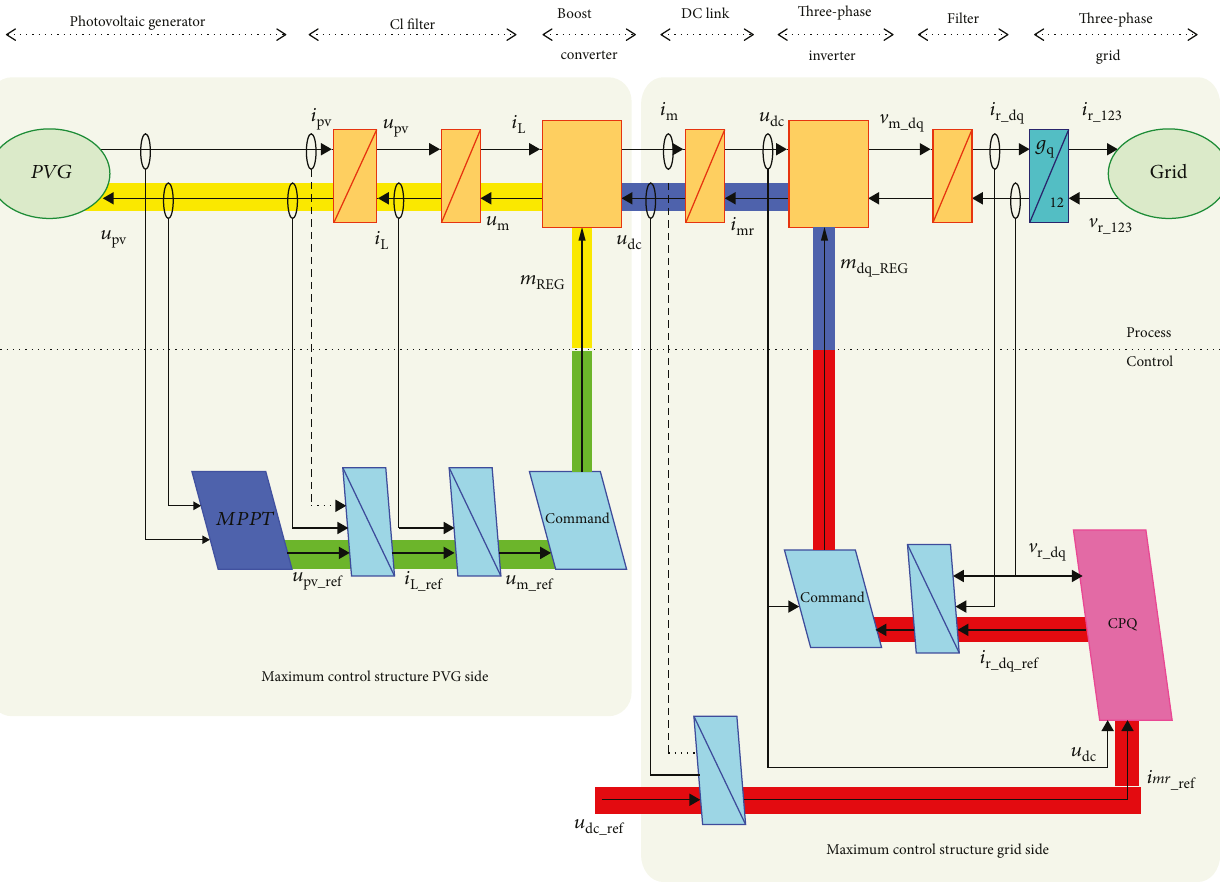
Figure 1: The EMR and its reverse MCS of the overall system.